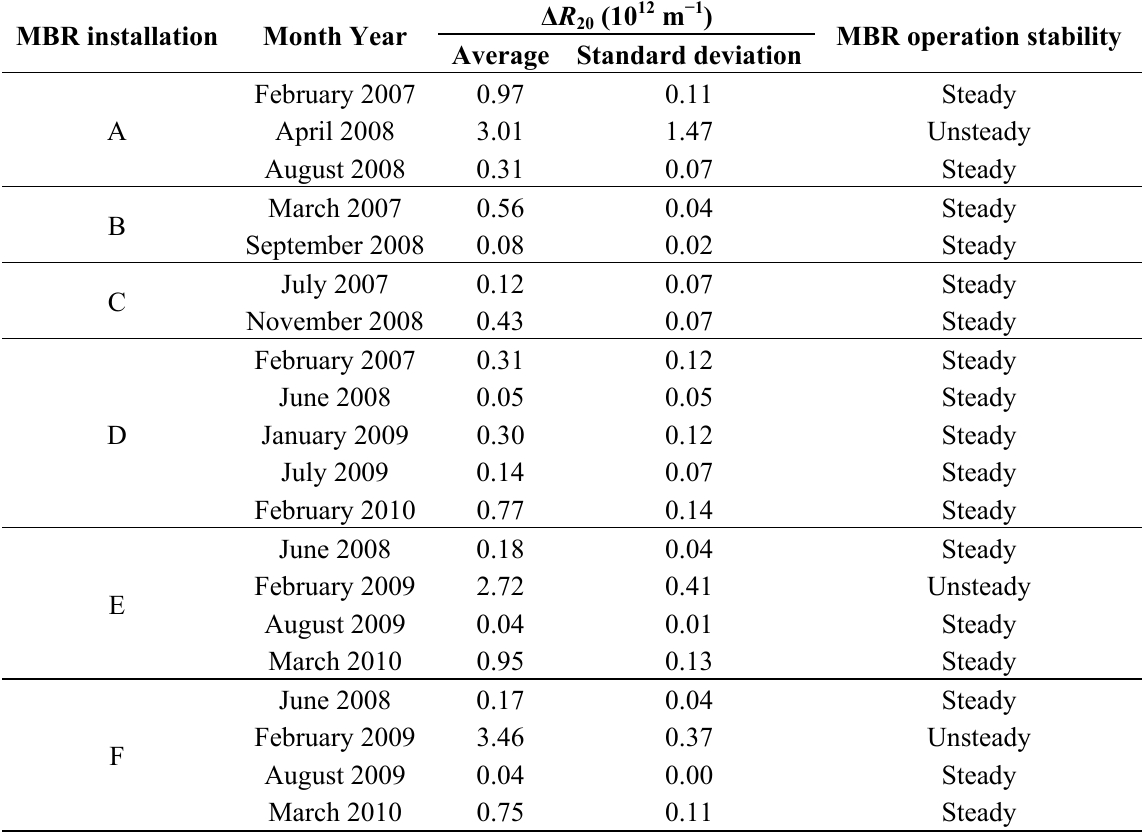
Table 7. Filterability, as Δ R and Krzeminski